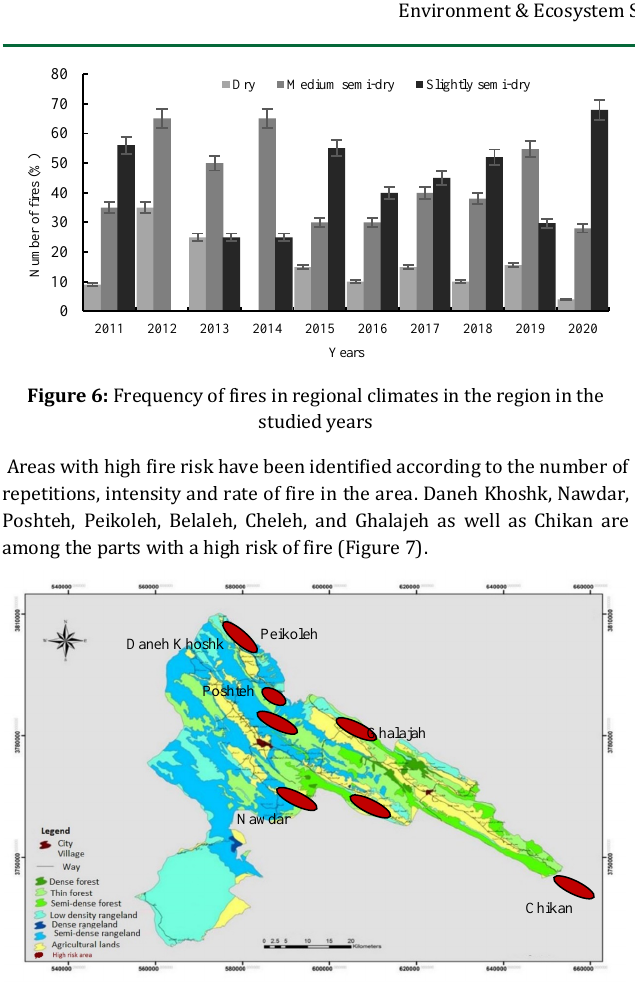
Figure 7: High risk areas Map of fires in forests and pastures of Gilan-e Gharb basin